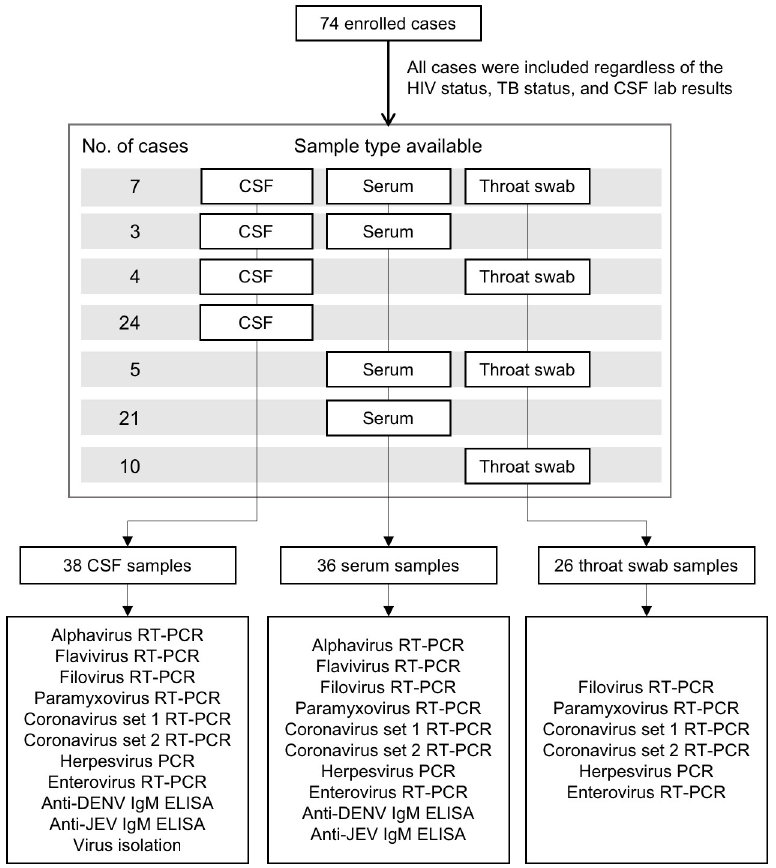
Fig 1. Flow diagram for total enrolled cases, collected samples available, and assays performed for different sample types in the study.